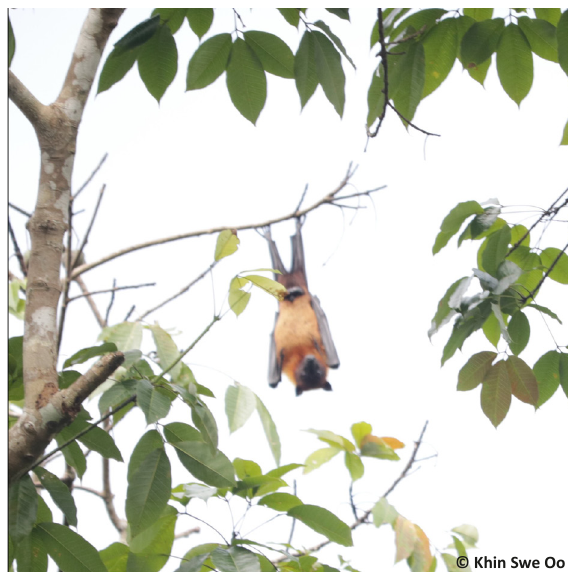
Table 4. The number of Flying Foxes recorded on roost trees in Tree species Shorea sp.